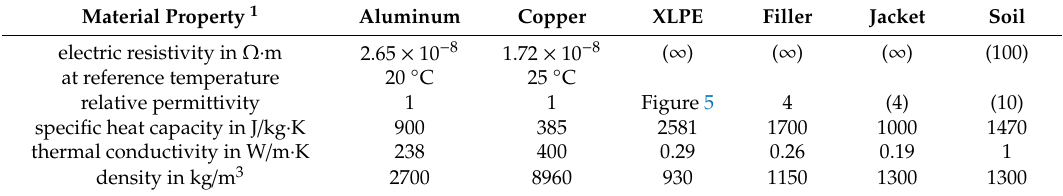
Table 3. Electrical and thermal properties; brackets indicate no relevance for the simulations.